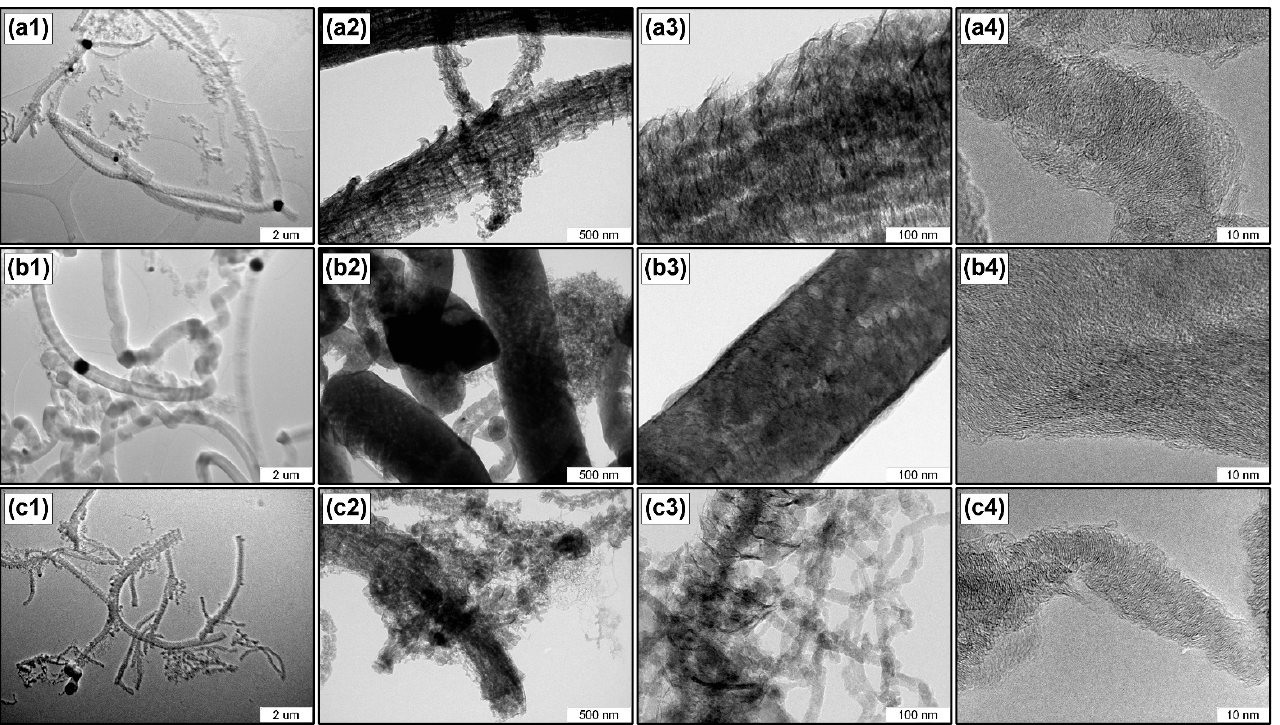
Figure 6. TEM images of the carbon nanostructures produced in different reactors: ( a1 – a4 ) reactor #1; ( b1 – b4 ) reactor #2; ( c1 – c4 ) reactor #3.